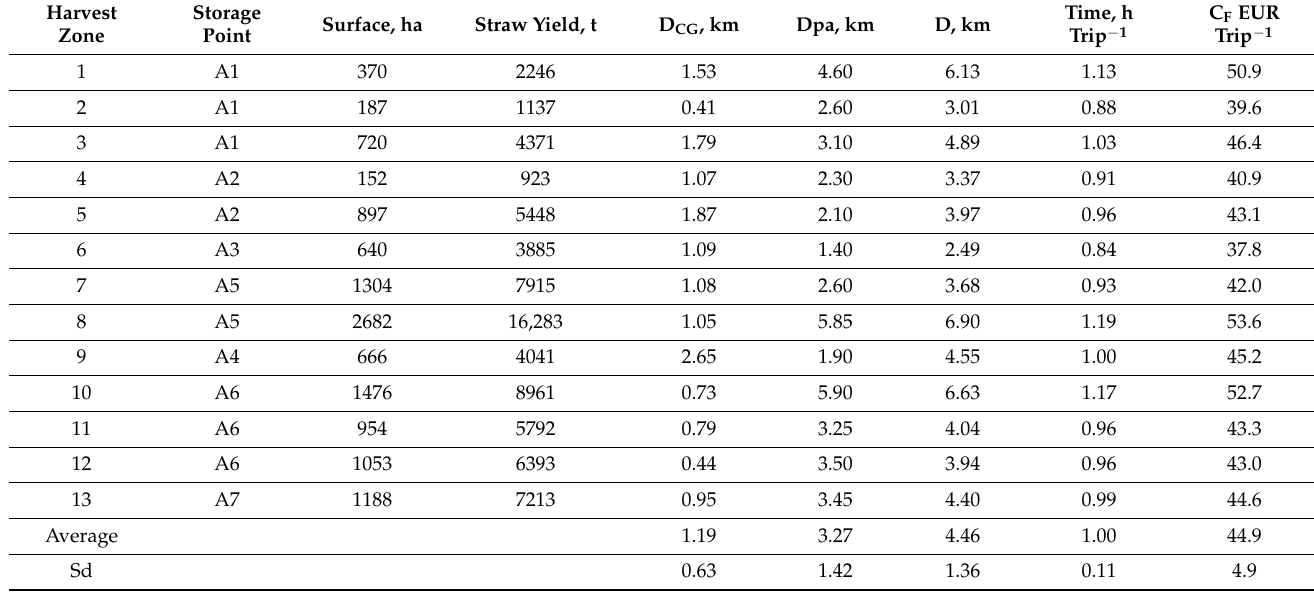
Table 7. Distances, surfaces, straw yield, and transport costs between the fields and the storage points in the production area. Harvest Zone